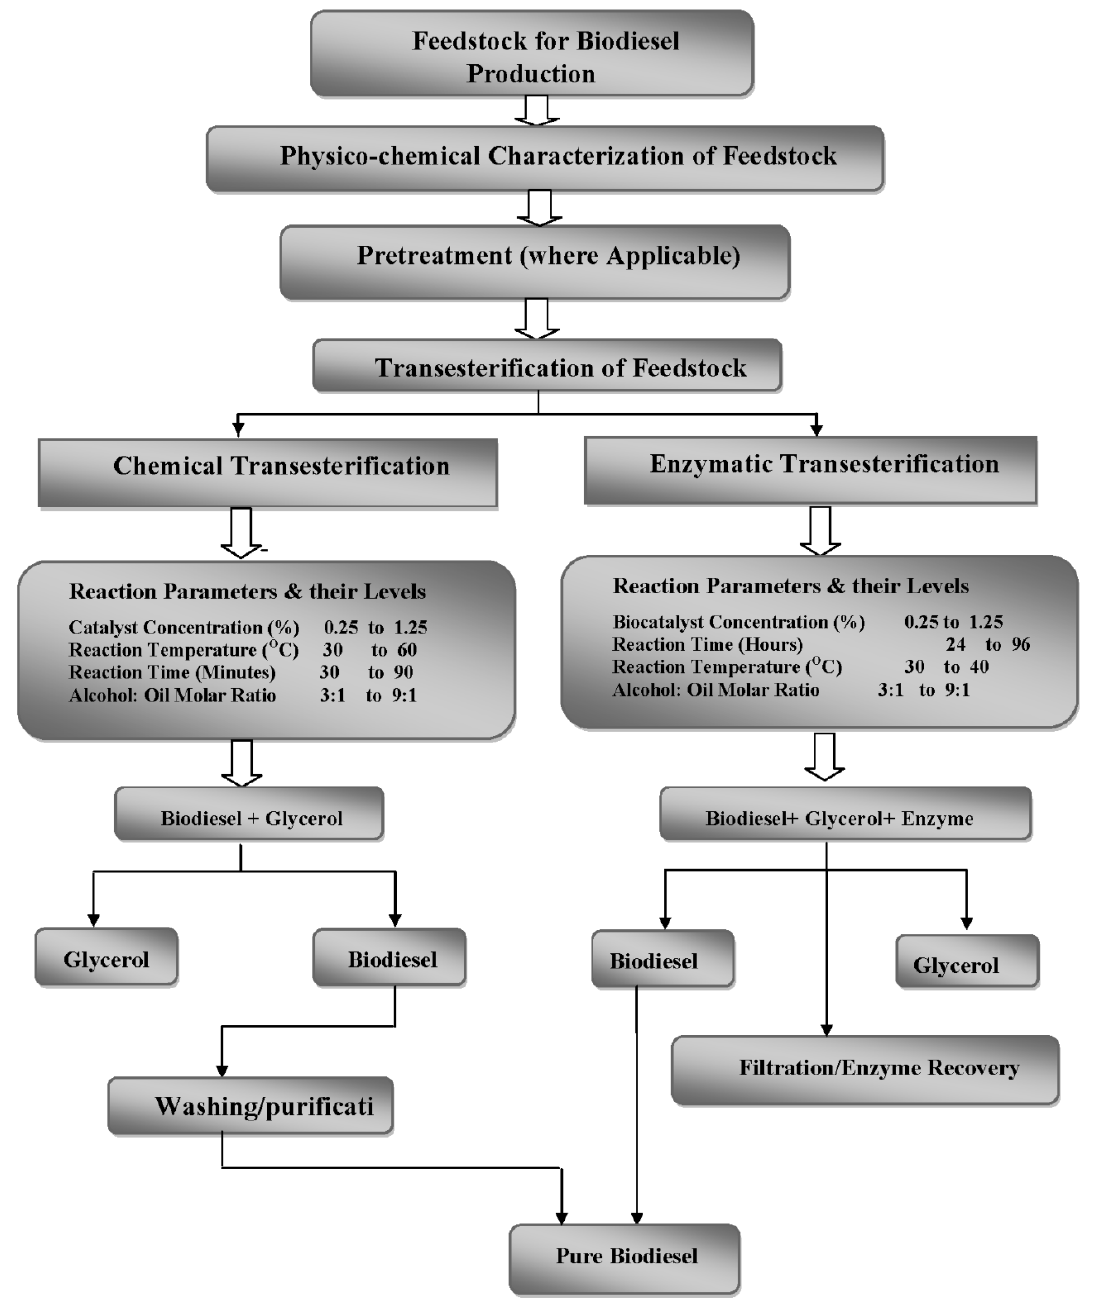
Figure 6. Schematic representation of chemical and enzymatic transesterification of vegetable